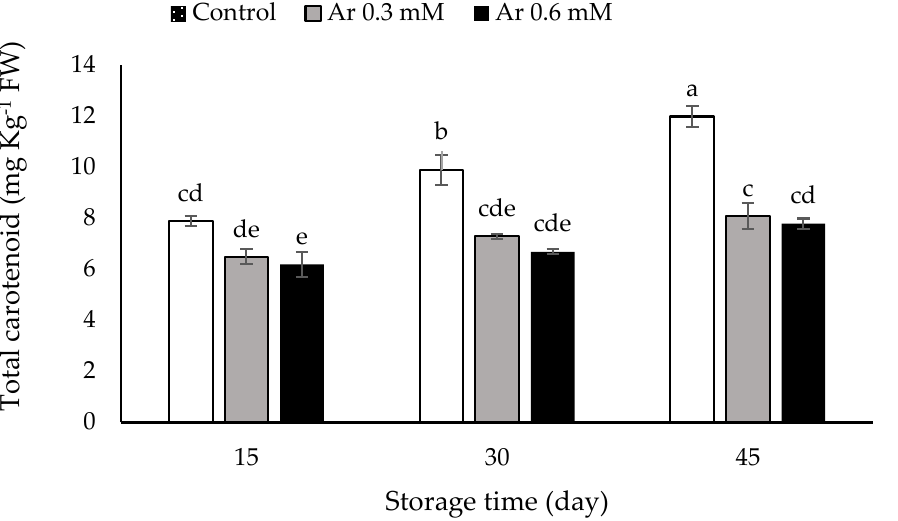
Figure 6. The effect of different levels of postharvest treatment of L-arginine on the total carotenoid of persimmon cv. “Karaj” fruits during cold storage (DMRT, p ≤ 0.05). The values of data are average of n = 3, and bar represents standard error of the means. Different letters above the bars show significant difference at p < 0.05 by Duncan’s multiple range test.